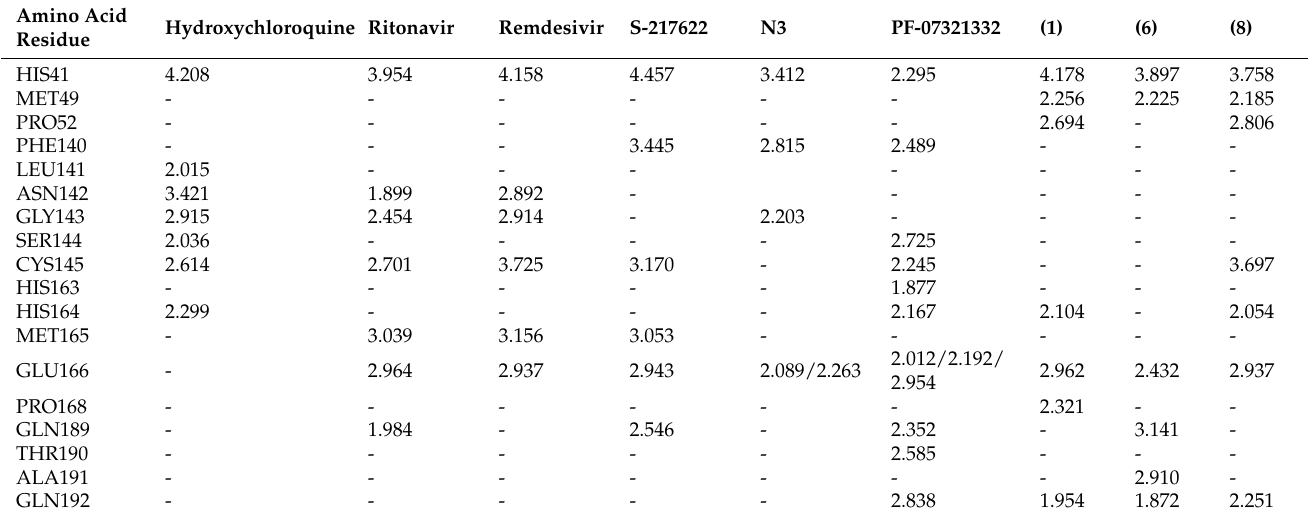
Table 3. Distance between the ligands (current medicaments, 1 , 6 and 8 ) and M pro within 5.0 Å from the molecular